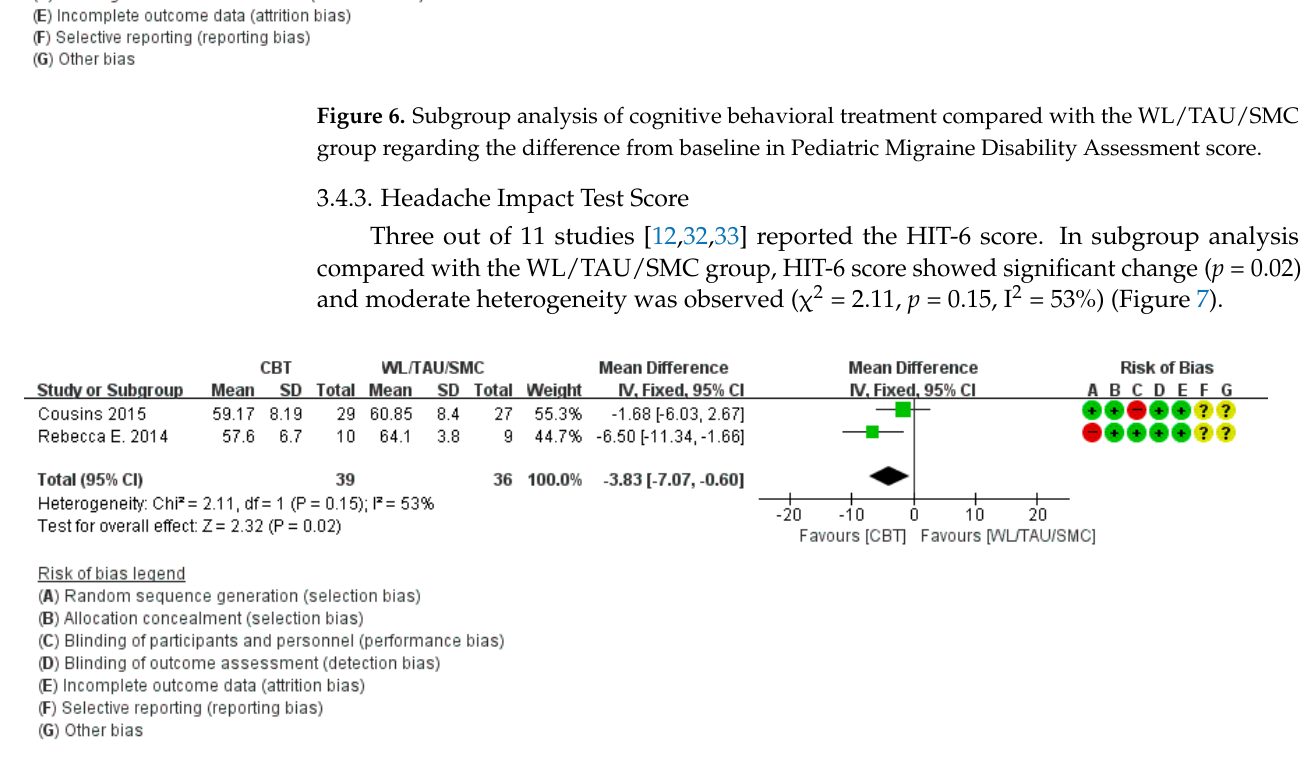
Figure 7. Subgroup analysis of cognitive behavioral treatment compared with the WL/TAU/SMC group for difference from baseline in Headache Impact Test (HIT-6)